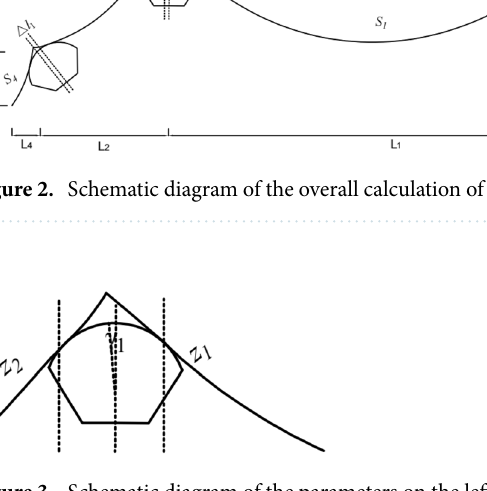
Figure 3. Schematic diagram of the parameters on the left tower